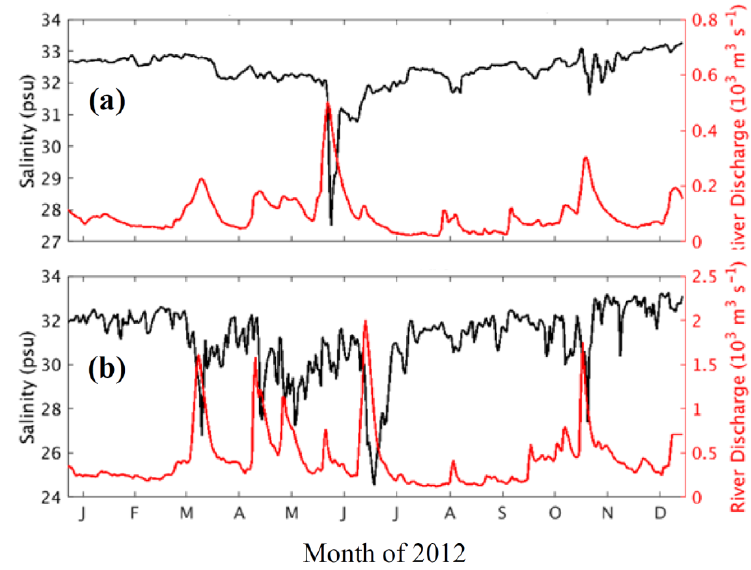
Figure 8. Daily time series of salinity (S) (black lines) and the river discharge (Q) (red lines): ( a ) S at station B01 vs. Q of the Saco River and ( b ) S at Station F01 vs. Q of the Penobscot river.